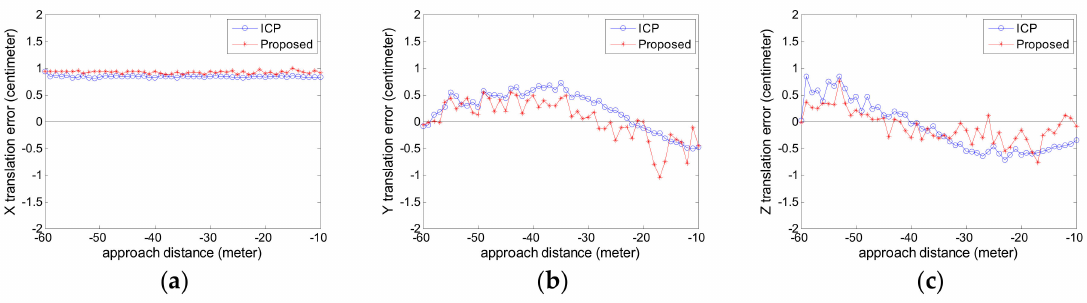
Figure 8. The position error curve in Experiment 1 ( a ) X translation error; ( b ) Y translation error; ( c ) Z translation